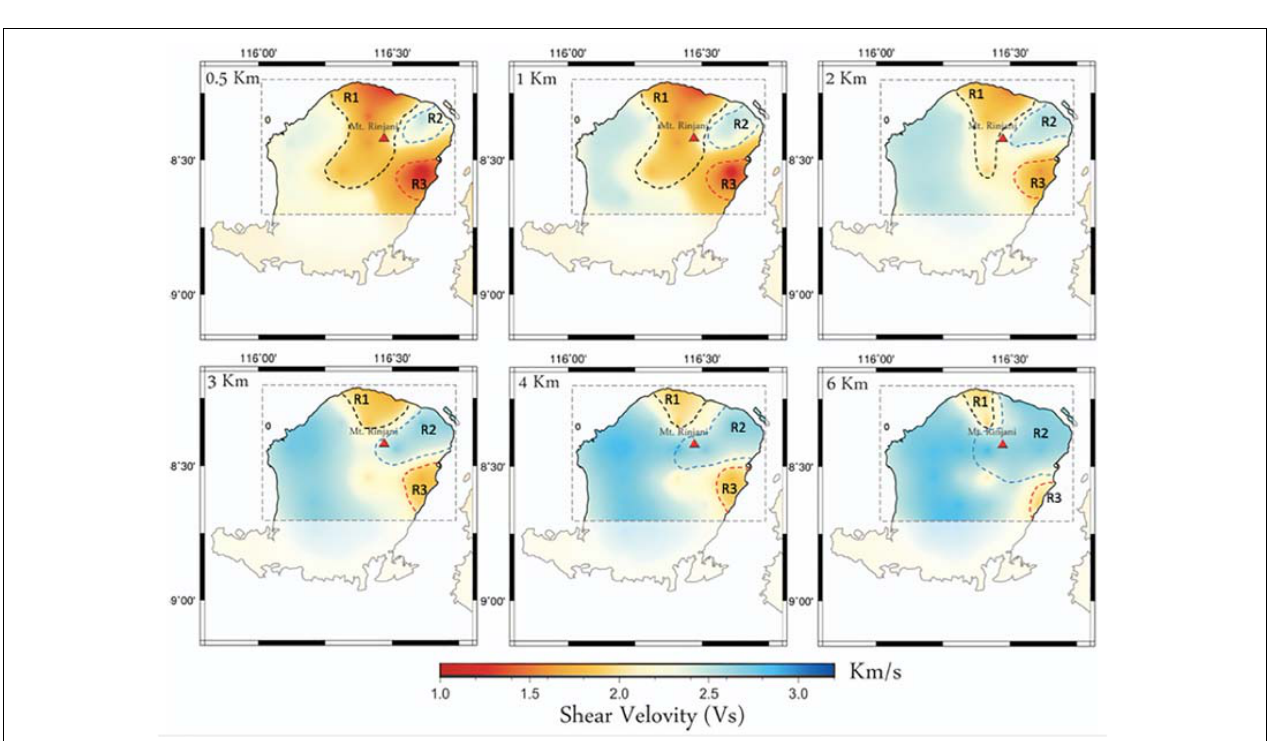
FIGURE 10 | The shear wave velocity (Vs) maps of Lombok for different depth ranges of 0.5, 1.0 , 2.0, 3.0, 4.0, and 6.0 km. The red triangle represents the Rinjani Volcano. R1, R2, and R3 zone marked by the black, blue, and red lines,